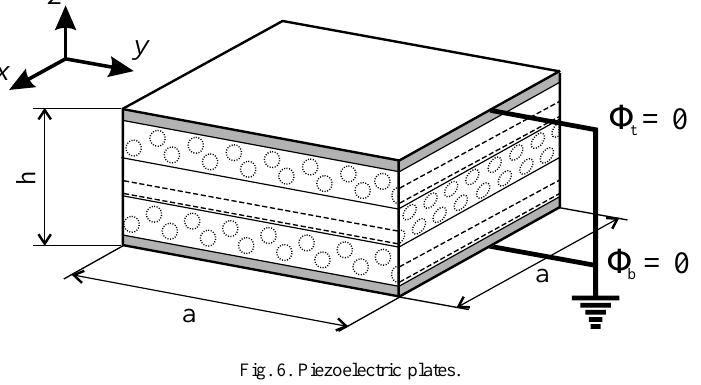
Fig. 6. Piezoelectric